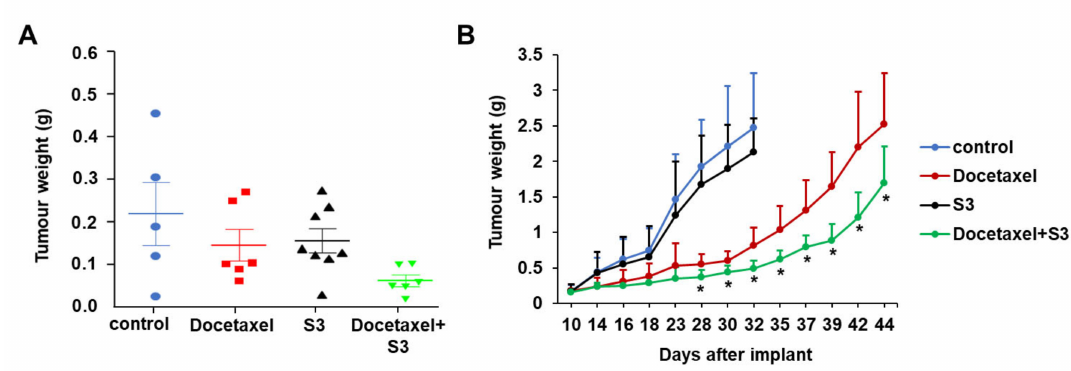
Figure 8. S3 potentiates the anti-tumour activity of Docetaxel in in vivo models of prostate cancer. ( A ) Male athymic nude-Foxn1 nu mice ( n = 8) were inoculated orthotopically with PC3 cells and treated with a combination of Docetaxel (3 mg / kg / week) and S3 (50 mg / kg / day) or each inhibitor alone for 28 days. ( B ) PC3 cells were inoculated subcutaneously in nude mice. When tumours reached the designated size, mice were treated with Docetaxel (3 mg / kg), S3 (50 mg / kg) or a combination of the two drugs. Control mice were treated with vehicle. Tumour weights were measured at the indicated days. Data are means + SD from n = 7 mice / group. * p <